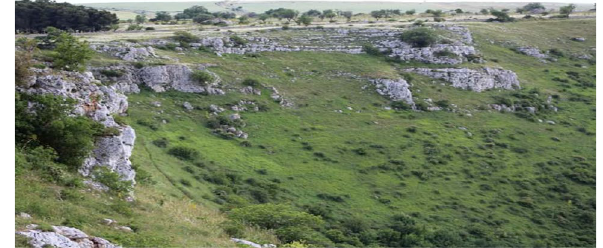
Figure 1. Typical landscape of Murge